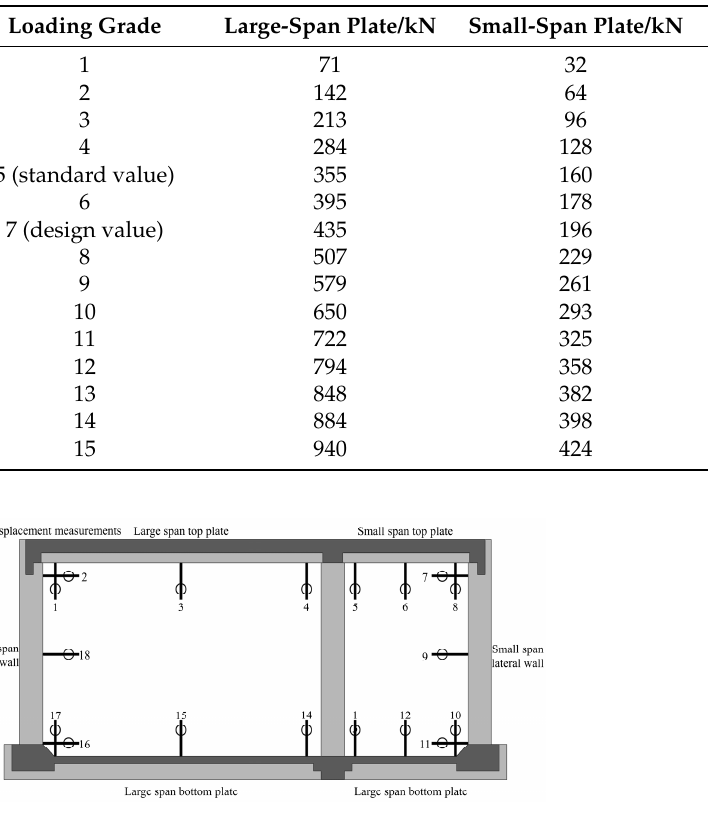
Figure 6. Distribution of displacement measurement points.